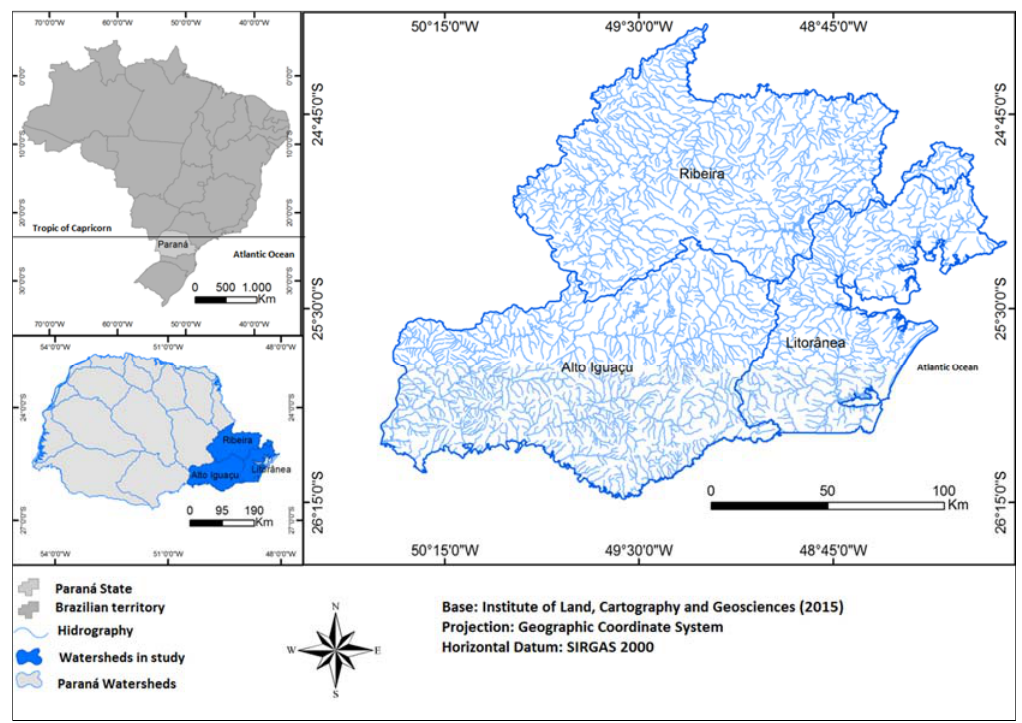
Figure 1. Location map of the Alto Iguaçu, Litorânea and Ribeira watersheds, Paraná State, Brazil.